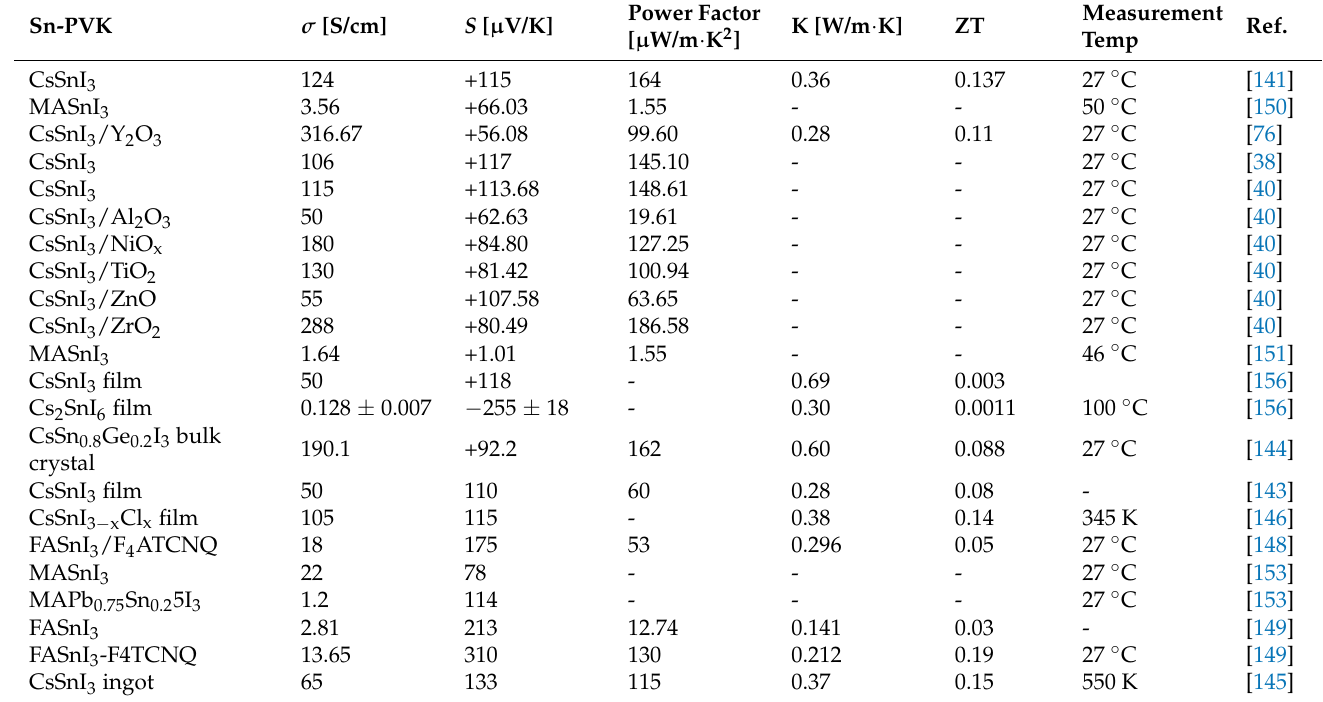
Table 6. The summary of the thermoelectric performance of Sn-PVK